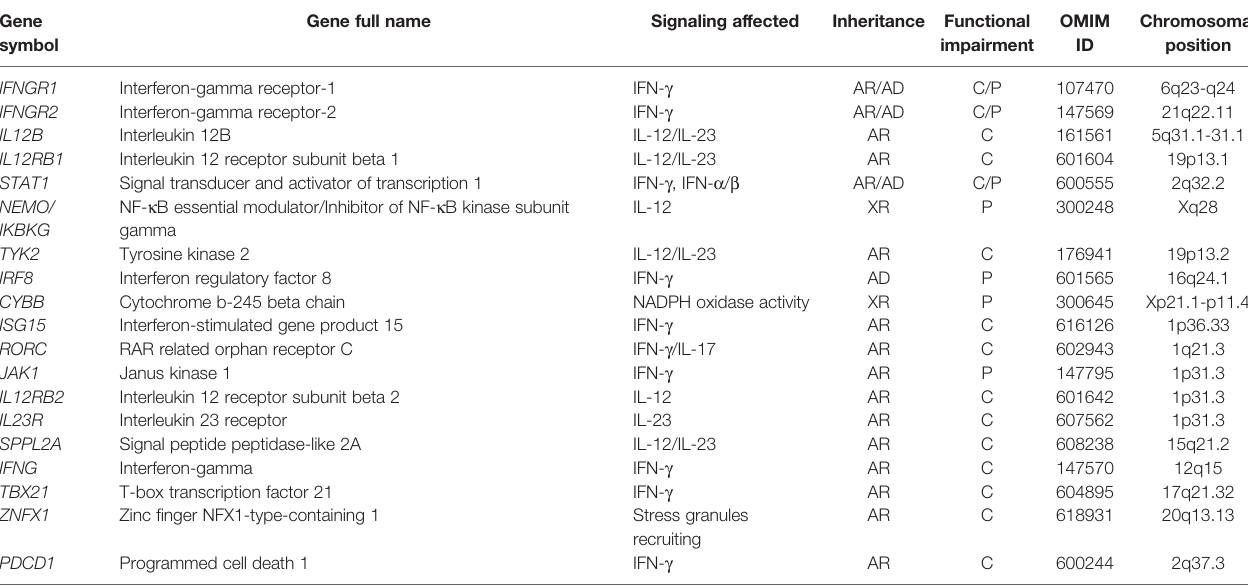
TABLE 1 | Overview of genetic etiologies involved in